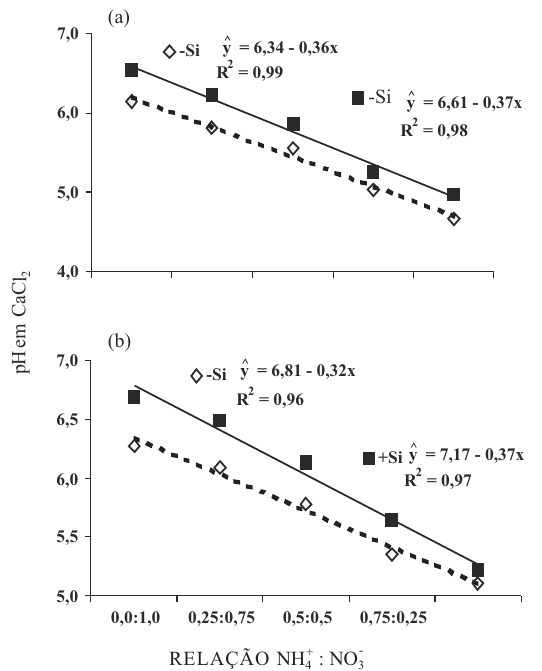
Figura 2. Valores de pH em CaCl diferentes relações N-NH 4+ : NO 3- na presença e ausência de Si. (a) solo não-rizosférico; (b) solo rizosférico.